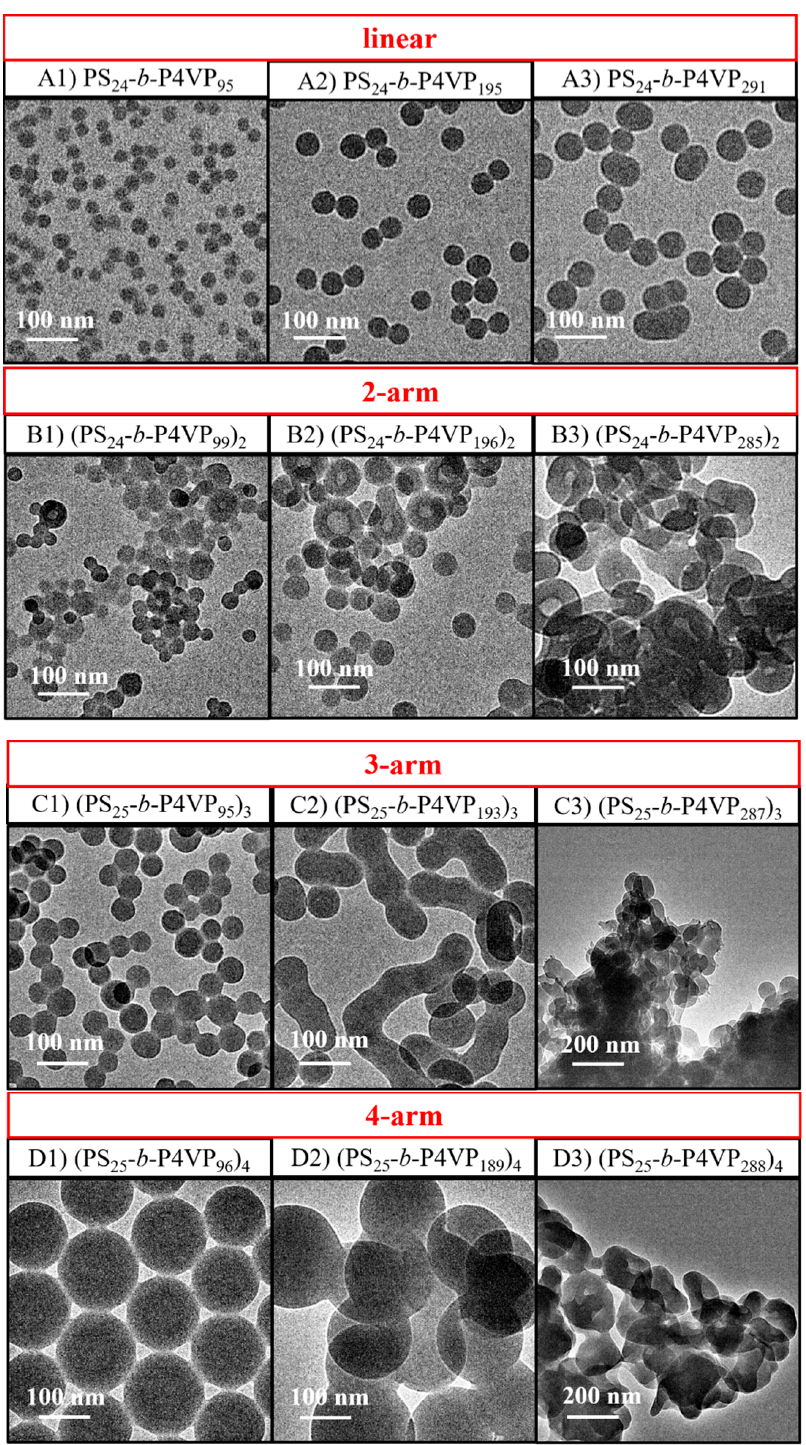
Figure 4. TEM images of (PS- b -P4VP) n nanoparticles containing similar PS segments but different P4VP segments.